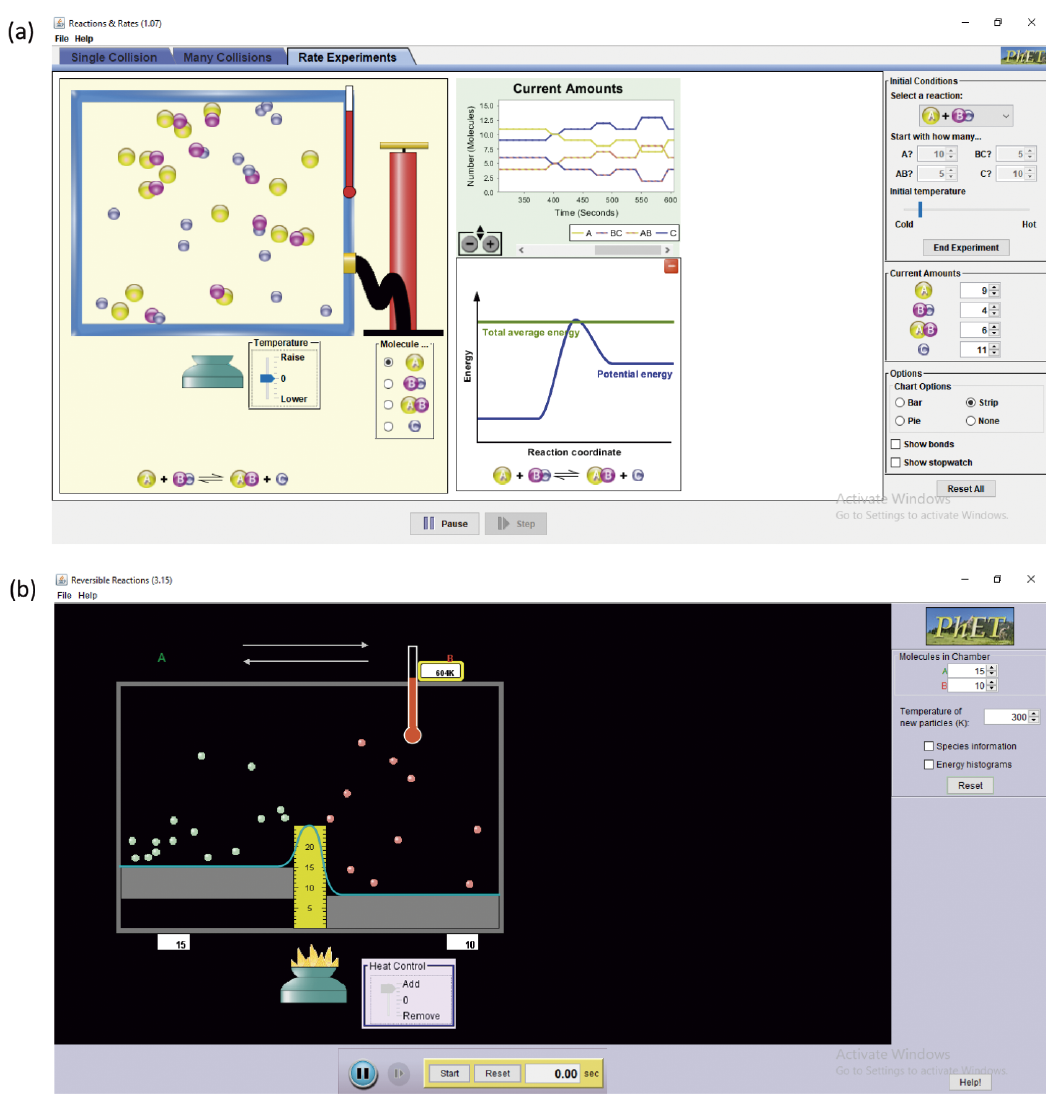
Figure 4. (a) Reaction & rates. (b) Reversible